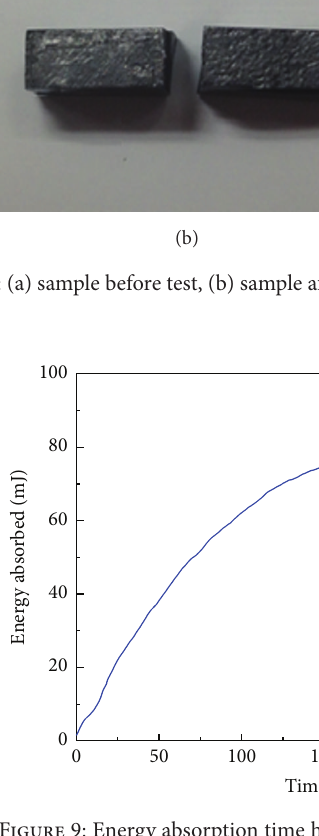
Figure 9: Energy absorption time history for the dynamic fracture test.